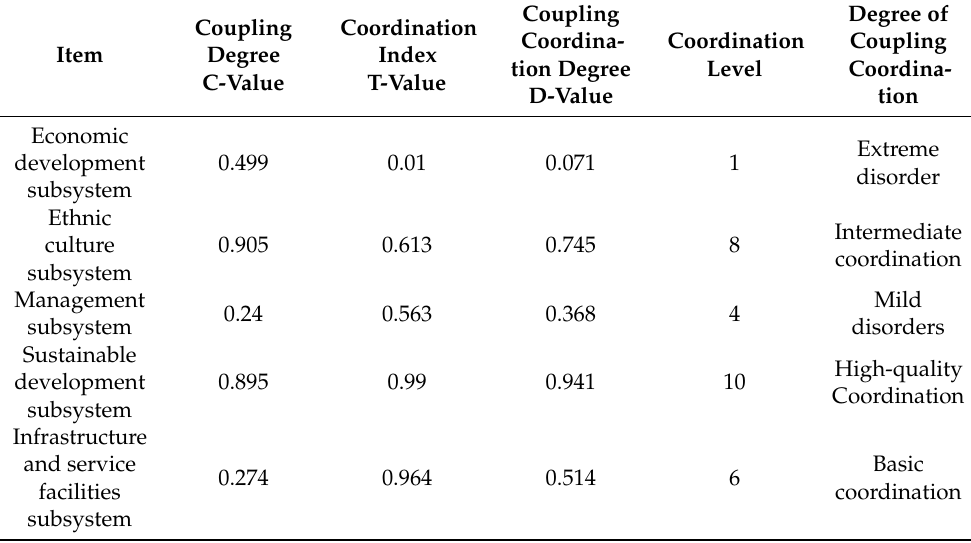
Table 7. Calculation Results of Coupling